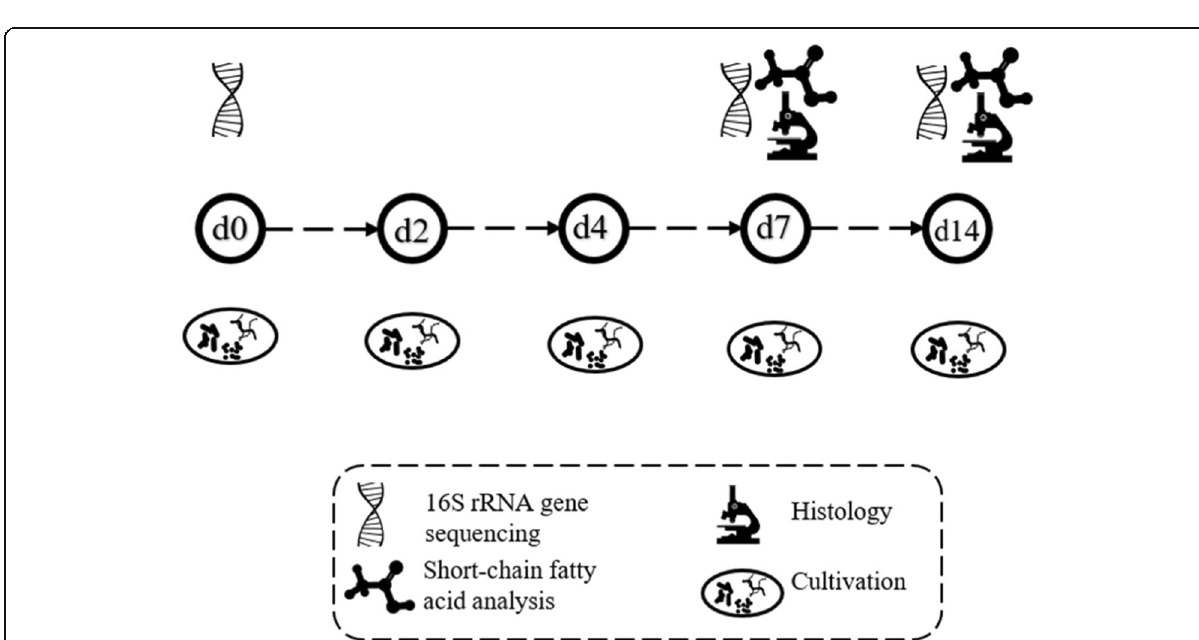
Fig. 1 The outline of the study sampling design. The timeline is shown as circles connected by the dashed line from left to right. It starts from day 0 PW (d0 corresponds to 28th postnatal day) and continues till day 14 PW (d14). The sampling procedures are given above (16S rRNA gene sequencing, histology, and short-chain fatty acid analysis) and below (cultivation) the